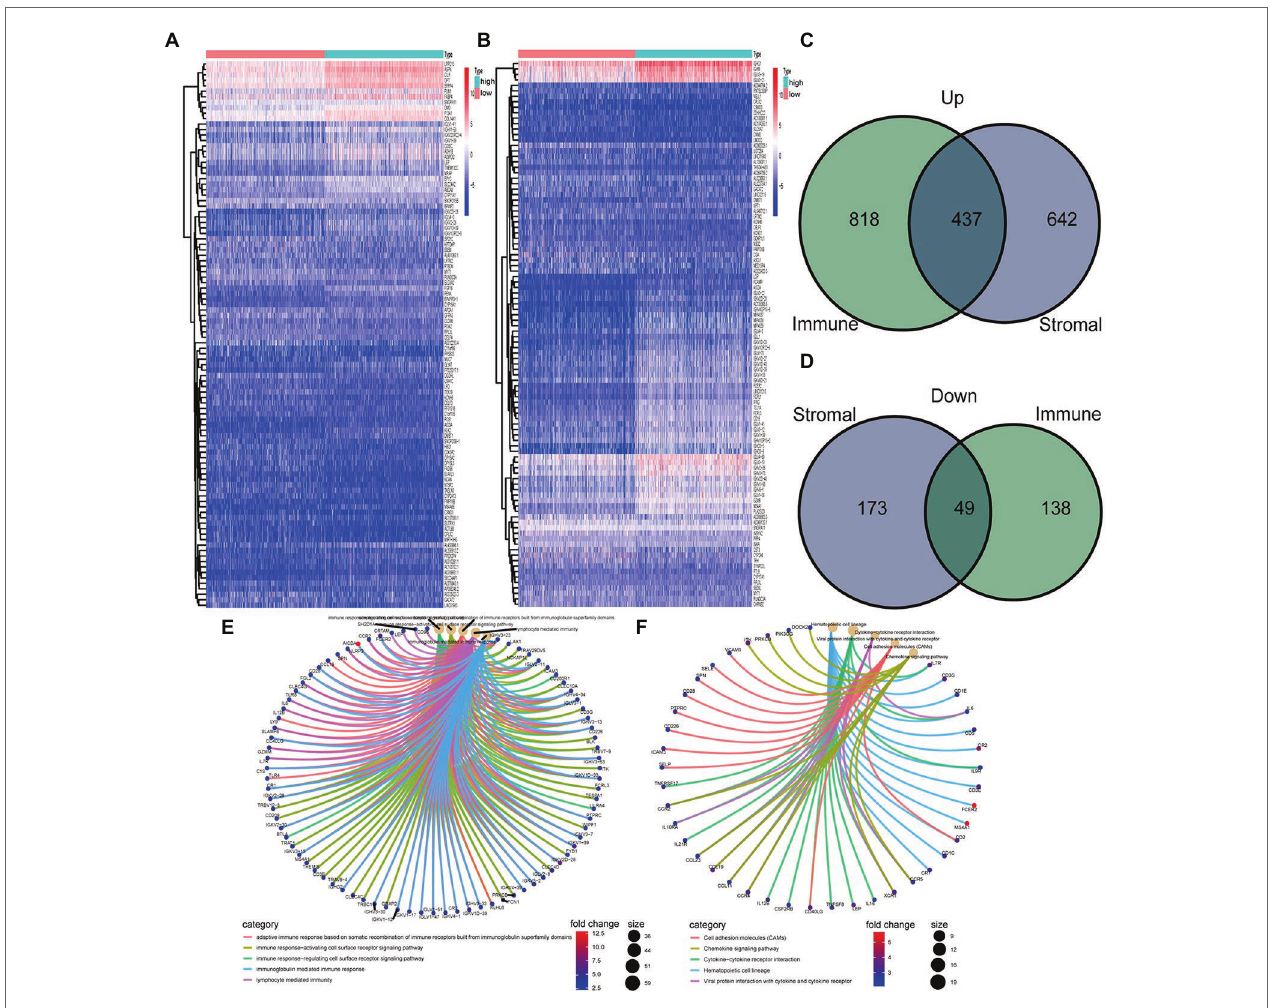
FIGURE 2 | Heatmaps, Venn plots, and enrichment analysis of gene ontology (GO) and Kyoto Encyclopedia of Genes and Genomes (KEGG) for differentially expressed genes (DEGs). (A) Heatmap for DEGs generated in StromalScore. (B) Heatmap for DEGs in ImmuneScore. (C,D) Venn plots were showing common upregulated and downregulated DEGs shared by ImmuneScore and StromalScore. (E,F) GO and KEGG enrichment analyses for